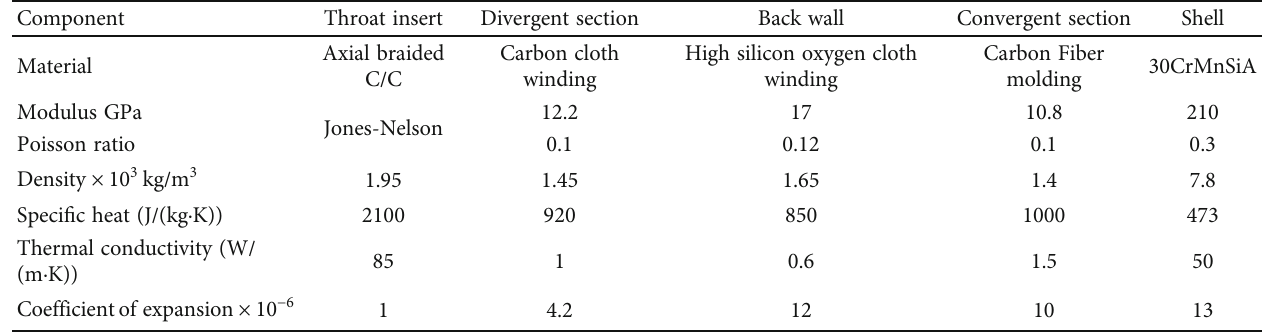
Table 2: Performance parameters of nozzle materials.